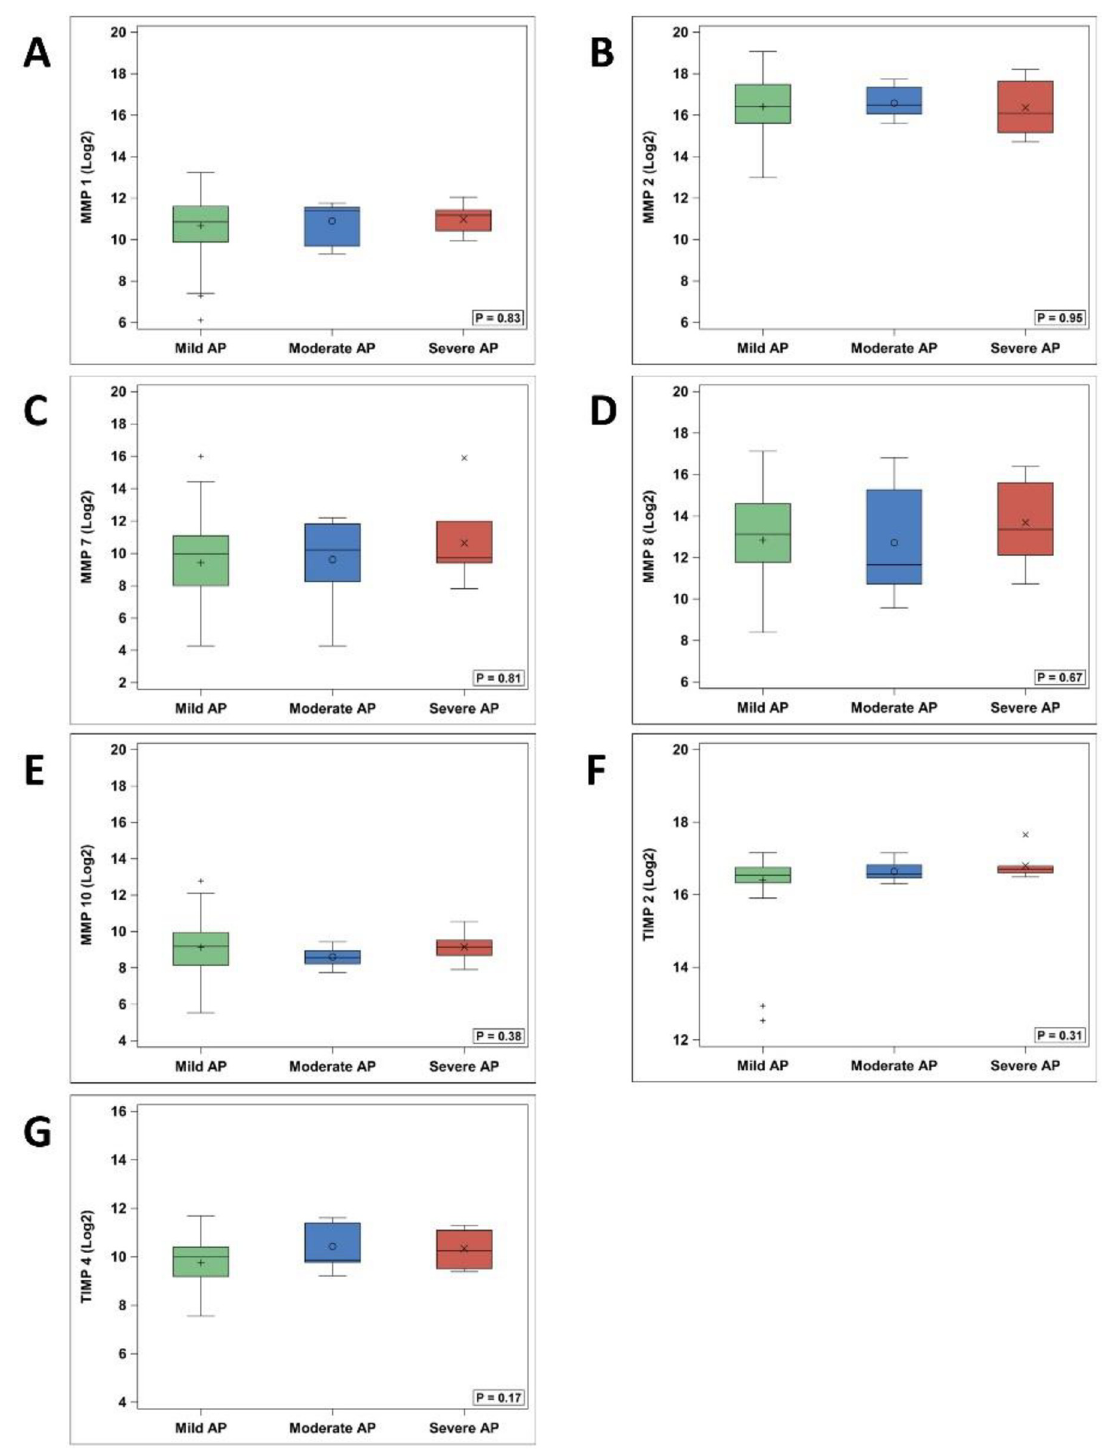
Fig 3. MMP-1, MMP-2, MMP-7, MMP-8, MMP-10, TIMP-2, TIMP-4 levels. AP = acute pancreatitis. MMP = matrix metalloproteinase. TIMP = tissue inhibitor of matrix metalloproteinase.